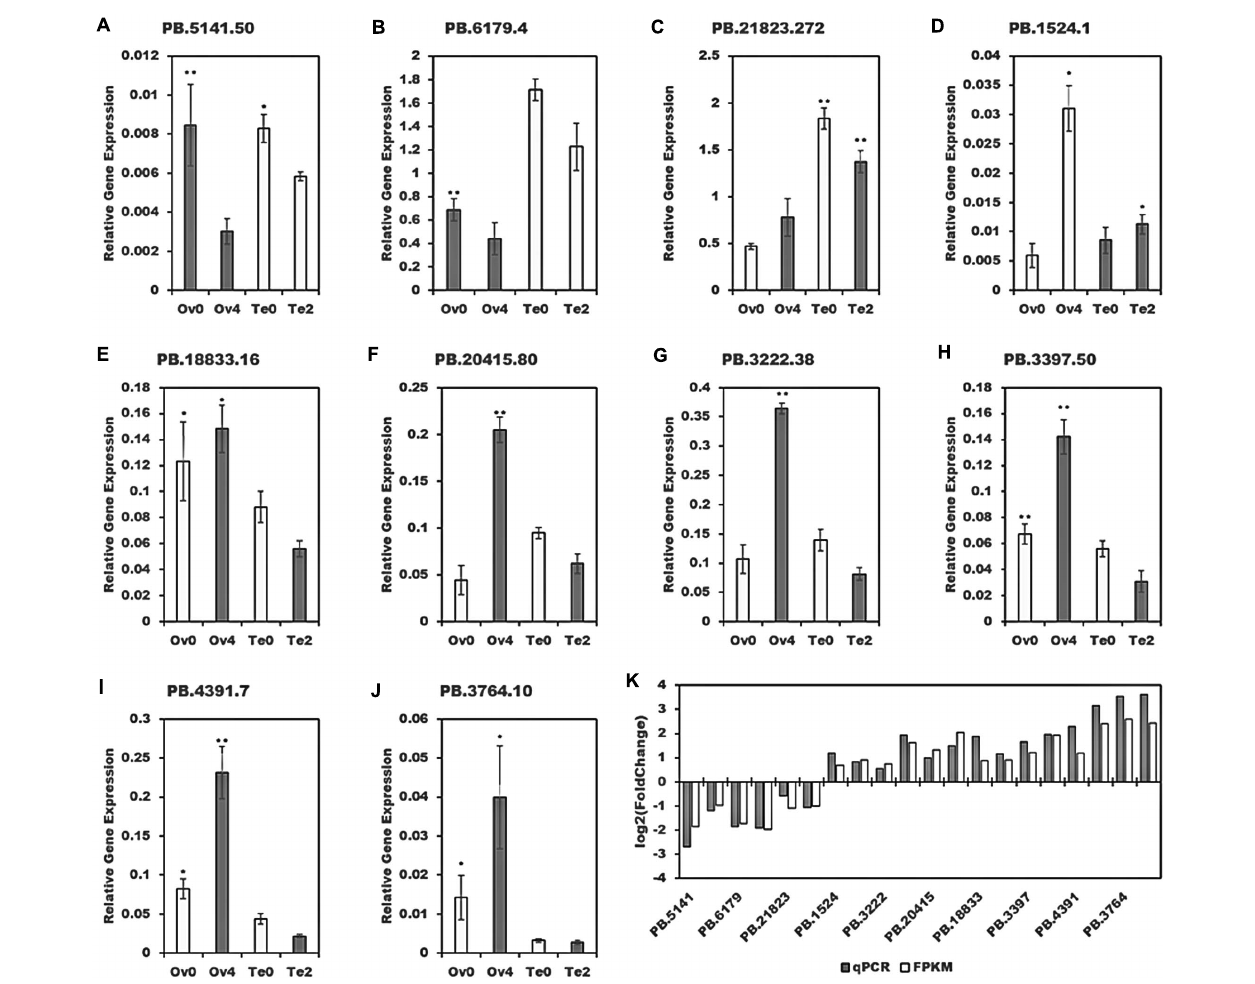
FIGURE 12 | Validation of 10 randomly selected sequences. * p < 0.05, ** p < 0.01. (K) The qPCR results were achieved by log 2 (Fold Change) and bioinformatic results by that based on FPKM. (A–J) The relative expression of 10 randomly selected